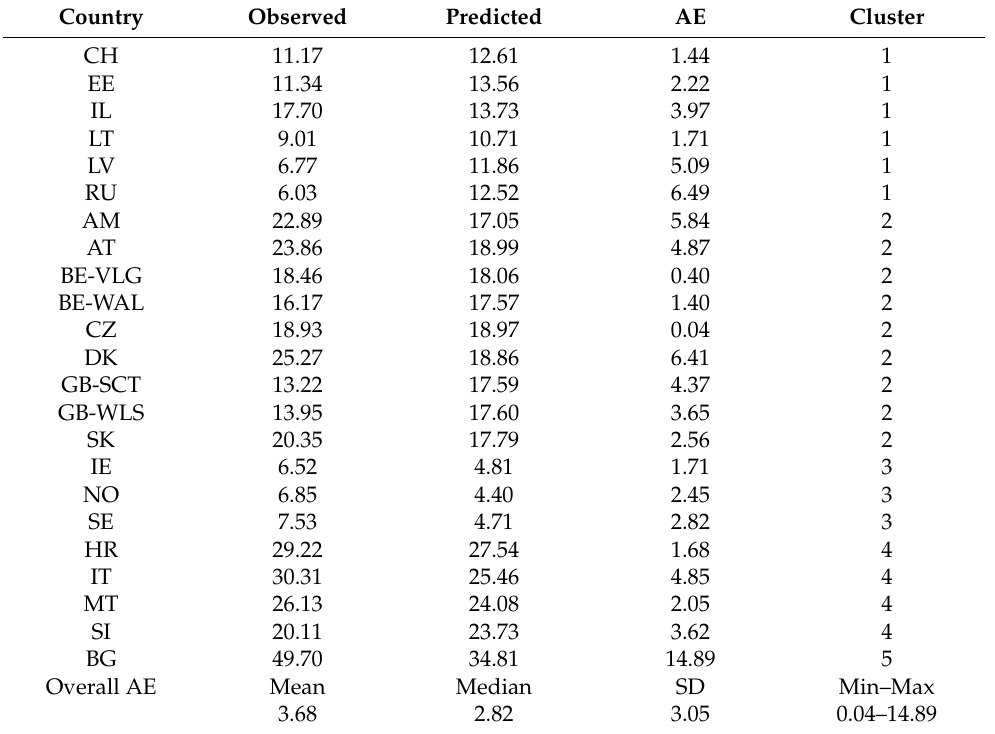
Table 4. Comparison between 2017/18 estimates and observed prevalence (%) among boys.